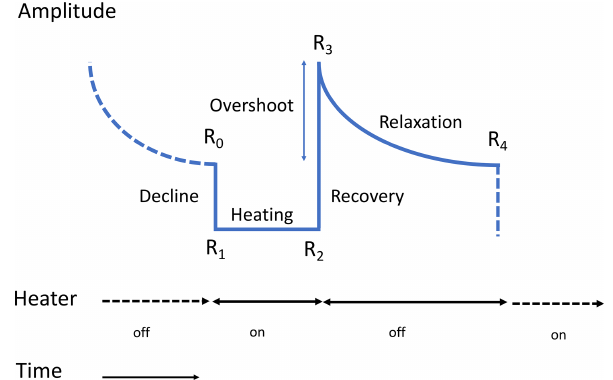
Figure 1. Sketch of the PMSE modulation due to HF heating in a typical overshoot curve; the power amplitudes during different times of the heating cycle are